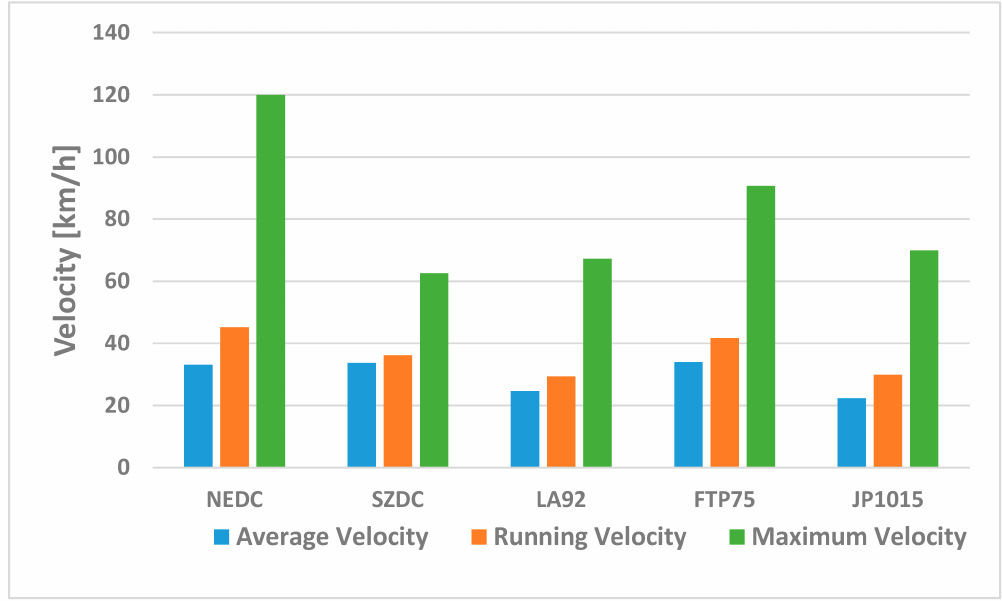
Figure 2. Comparison of velocity among various driving